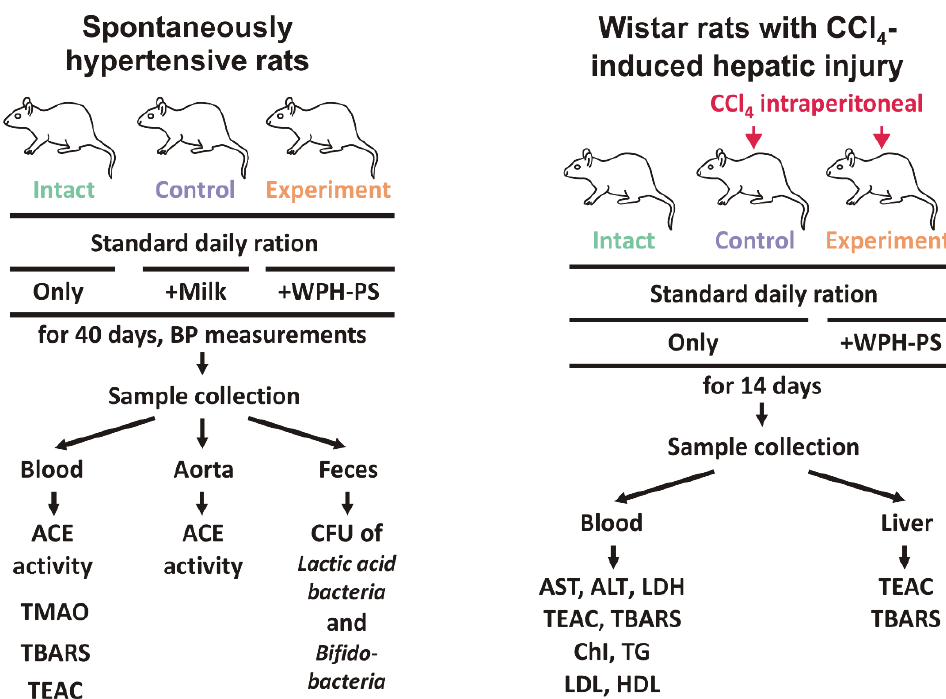
Figure 1. Experimental